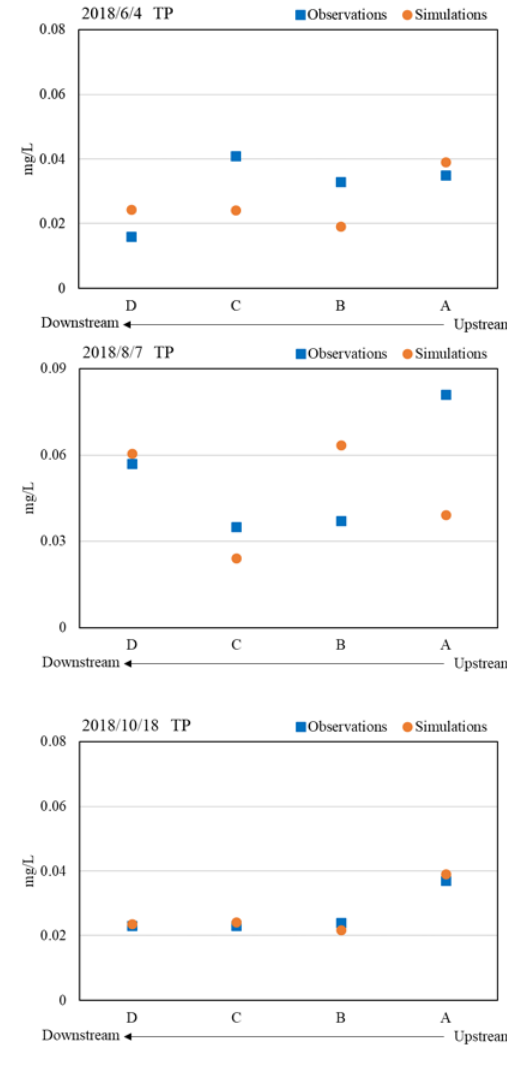
8 of 15 Figure 5. The model calibration (2015 data) and verification (2016 data) of the flow simulations of the SWMM. There are no water quality monitoring stations in the watershed, and so we performed onsite sampling in 2018. The daily flow simulations in 2018 were performed and validated before the water quality simulations. Four sampling points from upstream to downstream were surveyed. In addition, we sampled water in dry weather and wet weather to capture the effects of different pollution sources. The PS loads were calculated from reference data. We inputted the calculated PS loads into the model and used the dry weather data to verify the calculated PS value. Wet weather data verified the effects from NPSs. If the simulation results were far from the observations, then the coefficients for calculating the PS loads were adjusted. Similarly, the model parameters of the functions of the build-up and wash-off equations in the SWMM were calibrated by one set of wet weather data and verified by the others. The results of the simulations are shown in Figures 6 and 7. Notably, the introduced water quantity and quality were considered external inputs added to the model, which means the results of the simulations and observations included the effects of introduced water. There was a total of 7 dry-weather observations and 4 wet-weather observations. The MAPE result of the TP calibration during the dry-weather events was 26%, and the verification for the other 6 event results was 28%, implying that the PS load estimations were acceptable. The simulation results for wet weather were also satisfactory. The MAPE was 35% for the calibration of the 5/8 event and 19% for the verification events. The results of the simulations are summarized in Table 2. The